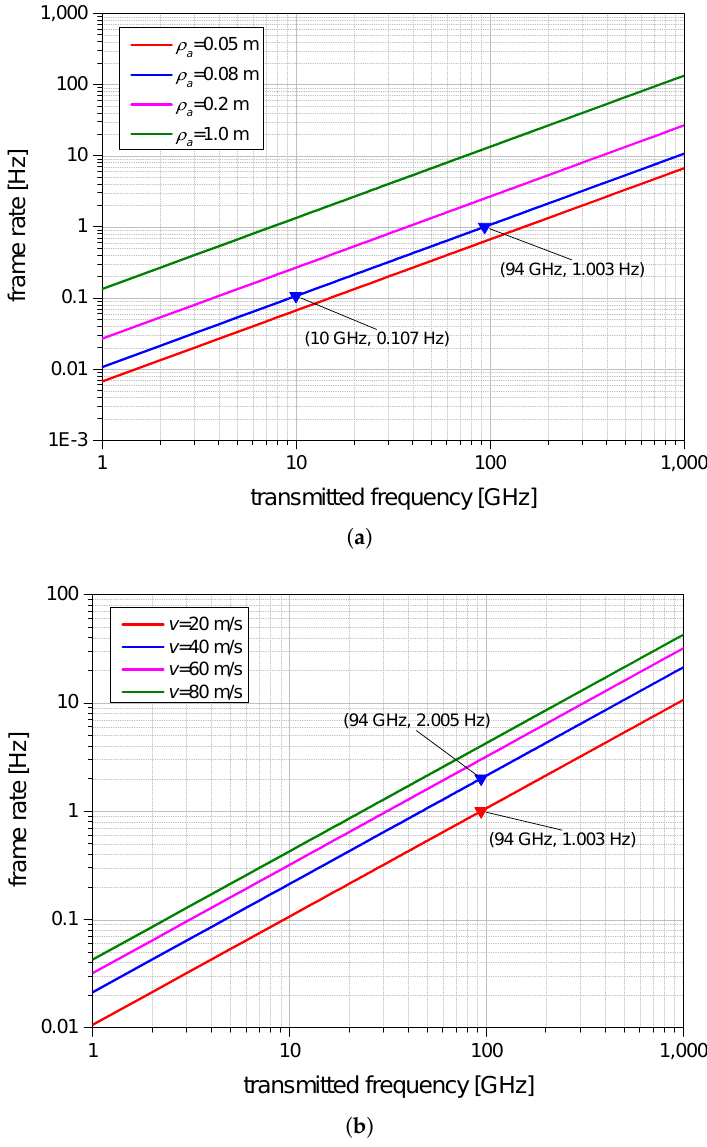
Figure 3. Frame rate of video SAR on a circular path: ( a ) varying resolution at v = 20 m/s; ( b ) varying platform velocity at ρ a = 0.08